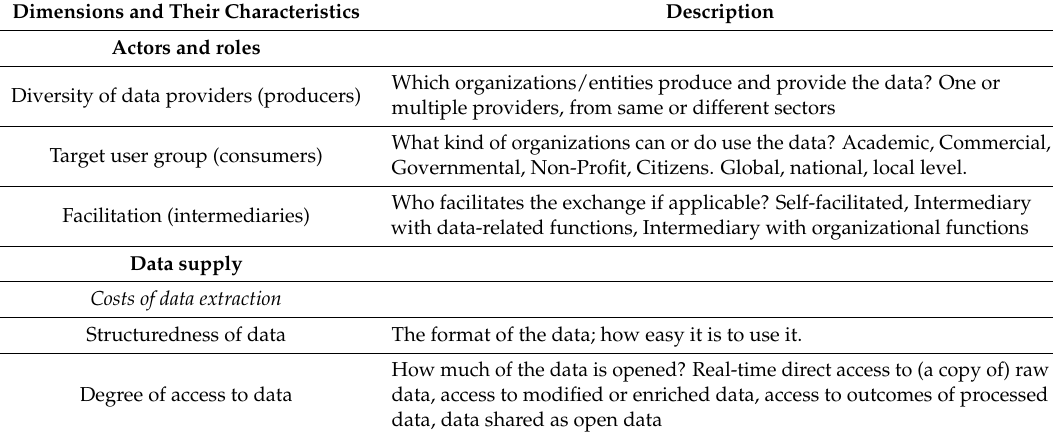
Table 1. An integrated framework to characterize data ecosystems on five dimensions with corresponding characteristics: actors, data supply, data infrastructure, data demand and data ecosystem